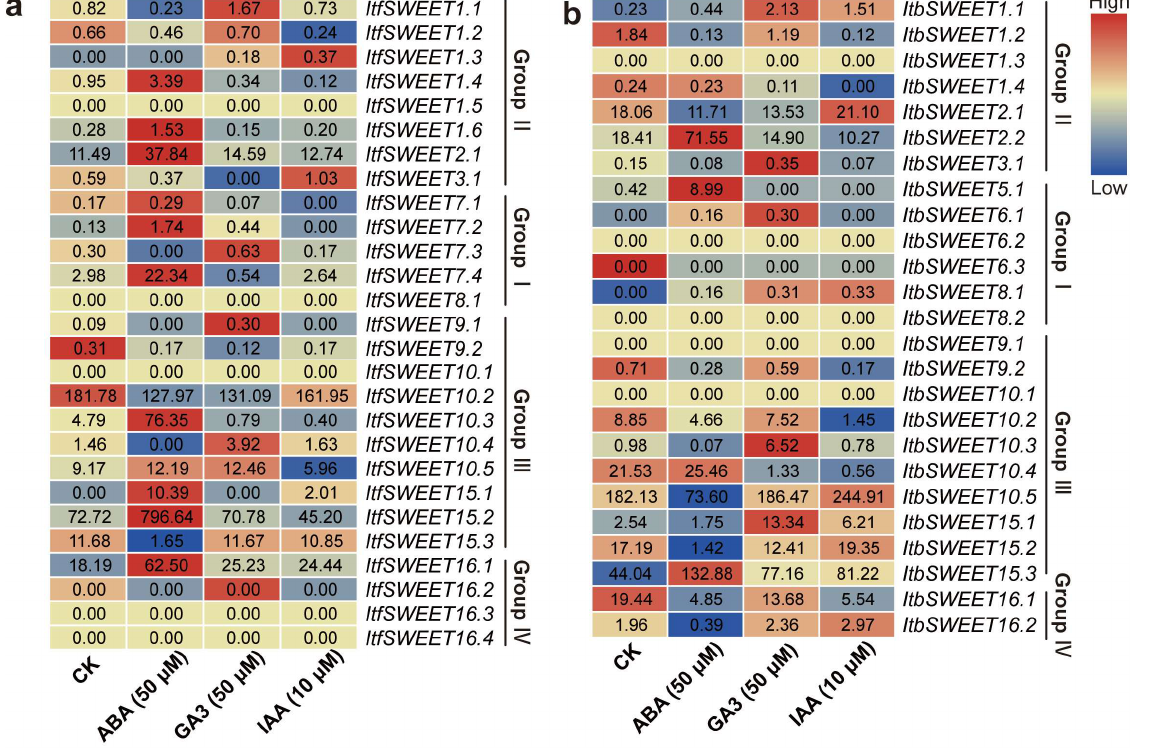
Figure 11. Gene expression patterns of SWEETs in response to different phytohormones (ABA, IAA, and GA) in I. trifida ( a ) and I. triloba ( b ) as determined by RNA-seq. The log 2 (FPKM+1) value is shown in the boxes.